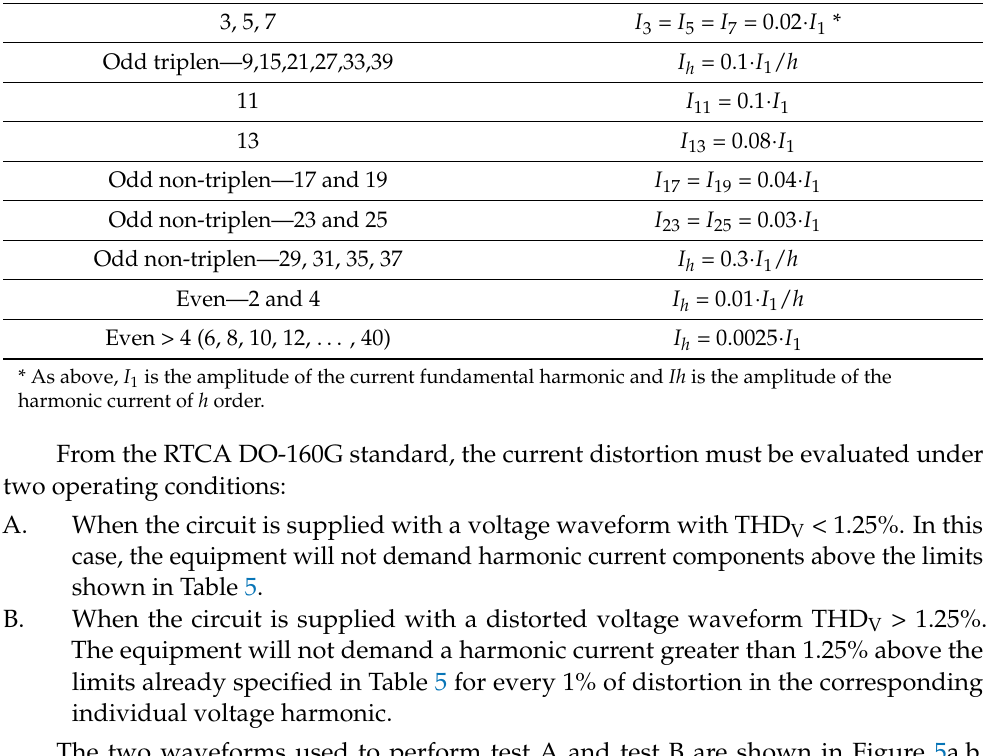
Table 5. Harmonic limits according to RTCA DO-160. Harmonic